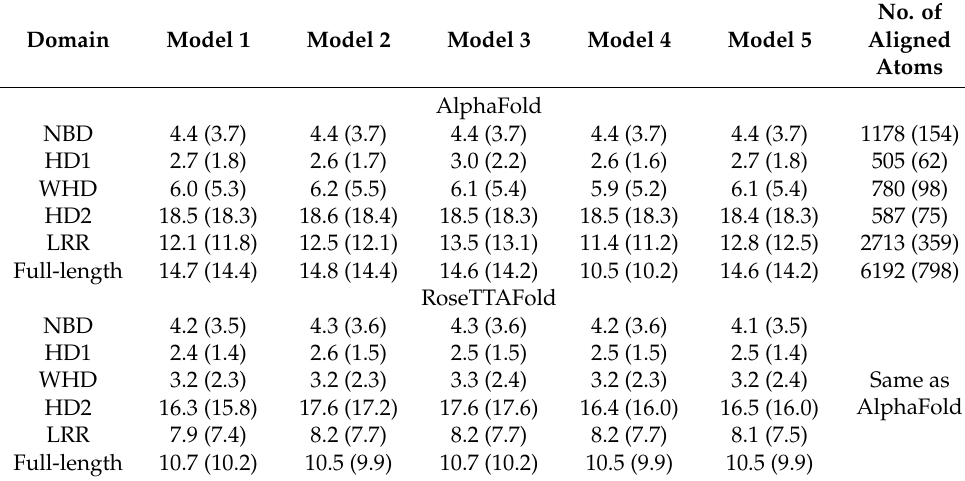
Table 2. RMSD values between the AI-predicted NLRP3 structures and one of the monomers in 7PZC (unit: